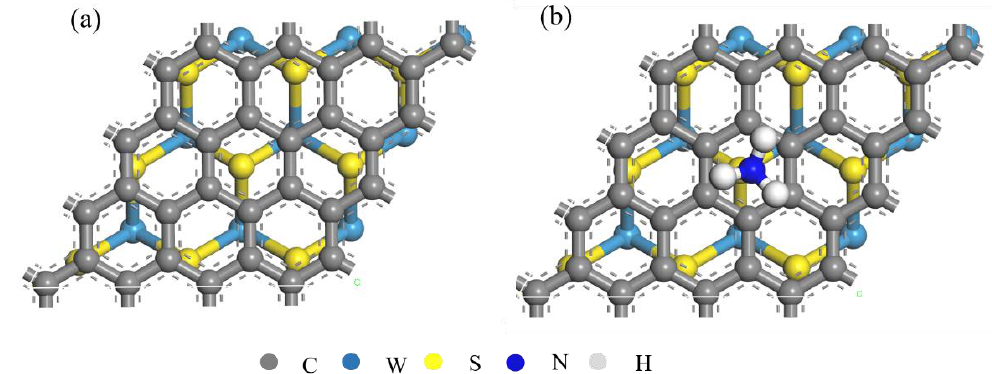
Figure 1. Top view of graphene/WS 2 composite structure matching mode. ( a ) Before adsorbing NH 3 , and ( b ) after adsorbing NH 3 . and ( b ) after adsorbing NH 3